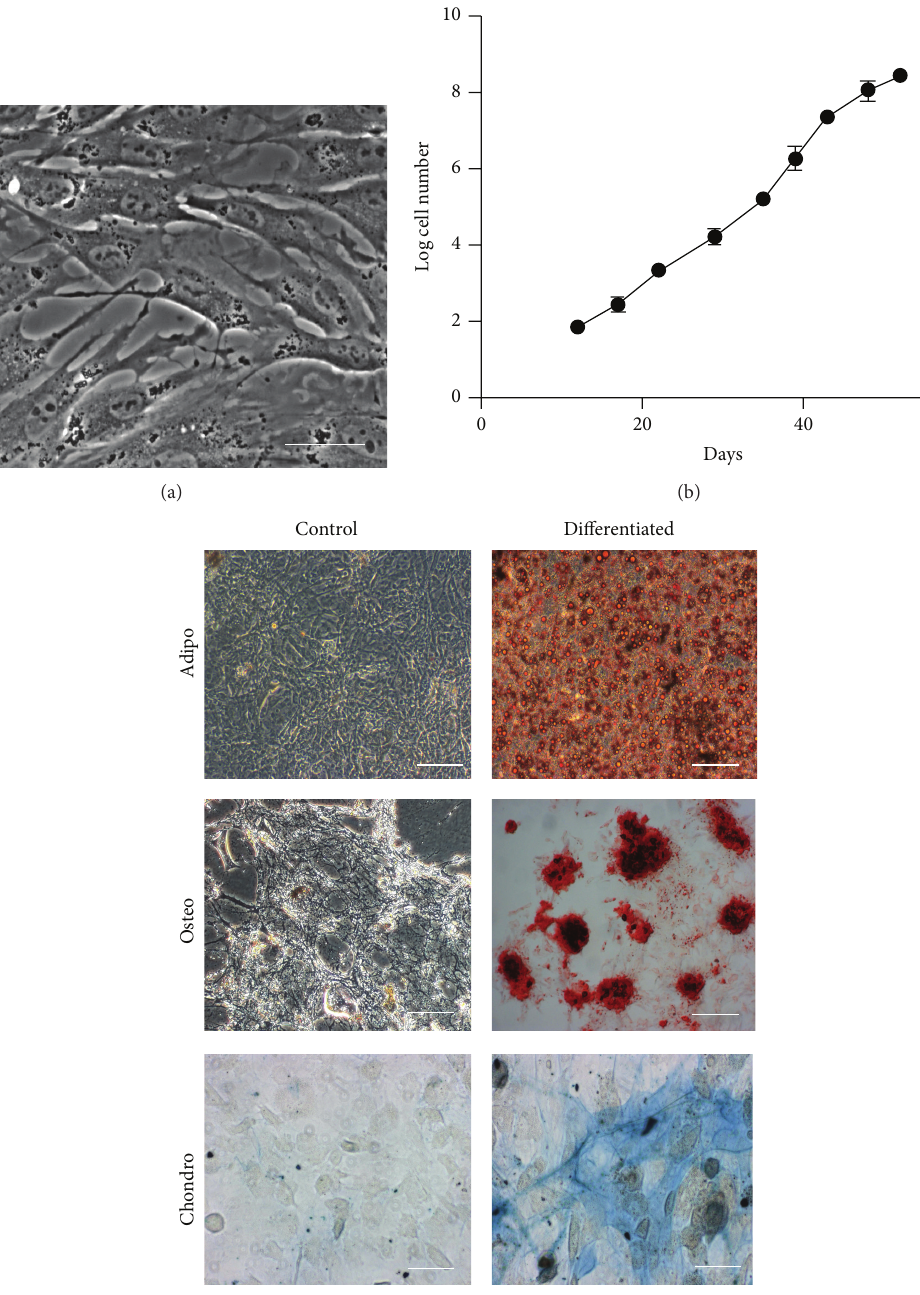
Figure 1: Morphology, proliferation, and differentiation potential of canine adipose-derived stem cells (ASCs). Cultures display the characteristic fibroblastoid morphology (a) and proliferation capacity (b) of ASCs from other species. ASCs are able to differentiate into adipogenic, osteogenic, and chondrogenic lineages, as shown by staining with Oil Red O, Alizarin Red S, and Alcian Blue, respectively (c). Undifferentiated (control) ASCs are not marked with these stains. Scale bars, 50 𝜇 m ((a) and (c) Chondro) and 100 𝜇 m ((c) Adipo,